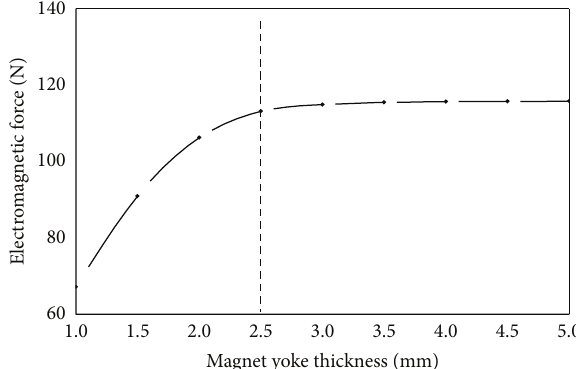
Figure 9: Influence of magnet yoke thickness on electromagnetic